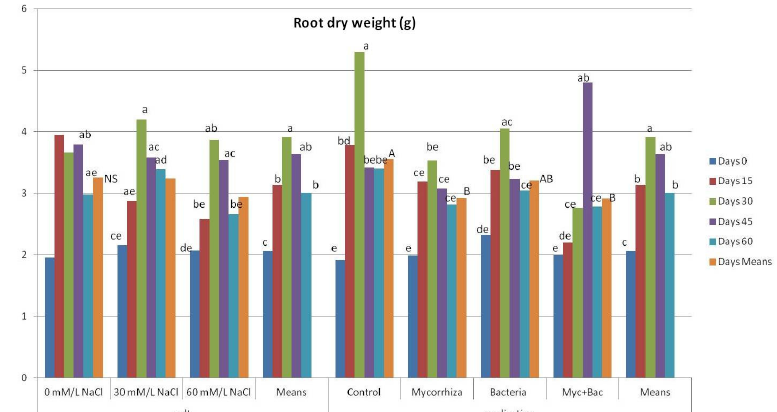
Fig. 4: Proline in the leaf tissues of strawberry cv. ‘San Andreas’ plants under salt (0, 30 and 60 mM/L NaCl) stress and applications (control, mycorrhiza, bacteria and myc+bac) for the periods of 0, 15, 30, 45 and 60 days.